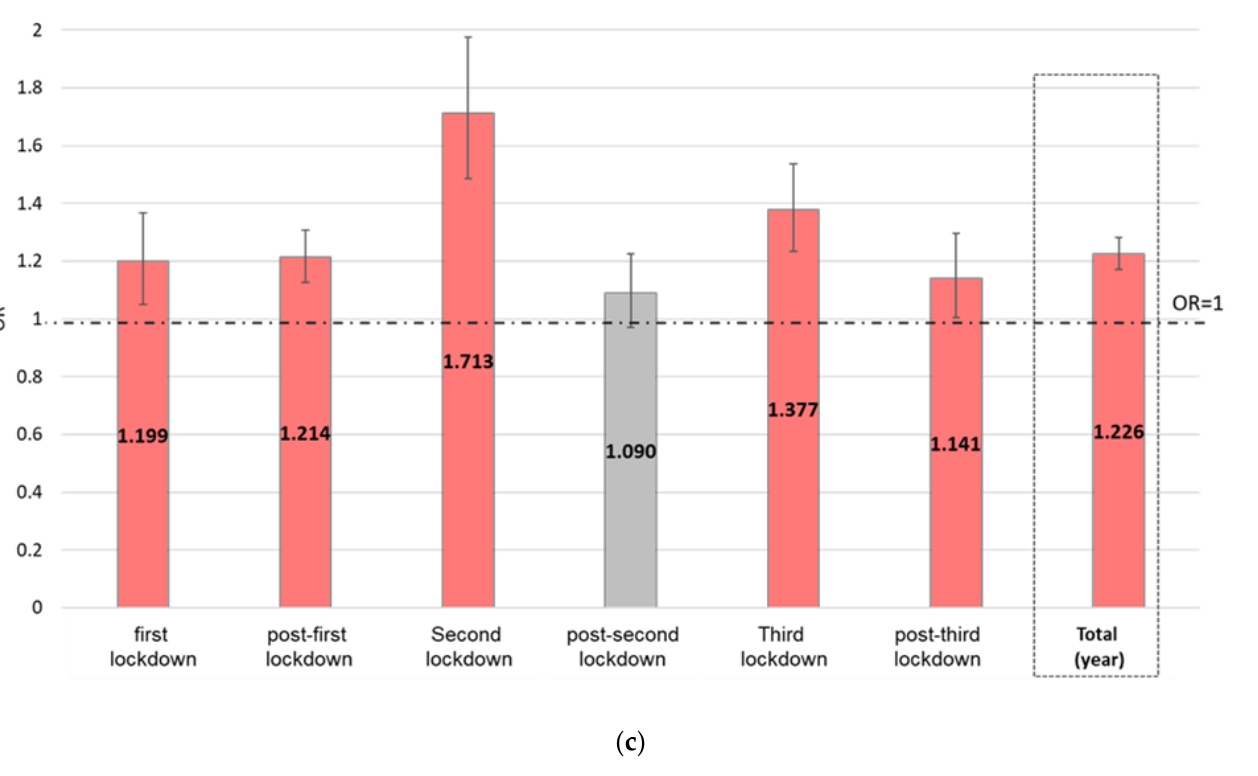
Figure 2. ( a ) STEMI adjusted case fatality rate during the Corona year vs. the corresponding baseline periods in the preceding three years (OR from GEE logistic models, adjusted for age, sex, and CCI). ( b ) Non-STEMI adjusted case fatality rate during the Corona year vs. the corresponding baseline periods in the preceding three years (OR from GEE logistic models, adjusted for age, sex, and CCI). ( c ) CHF adjusted case fatality rate during the Corona year vs. the corresponding baseline periods in the preceding three years (OR from GEE logistic models, adjusted for age, sex, and CCI).